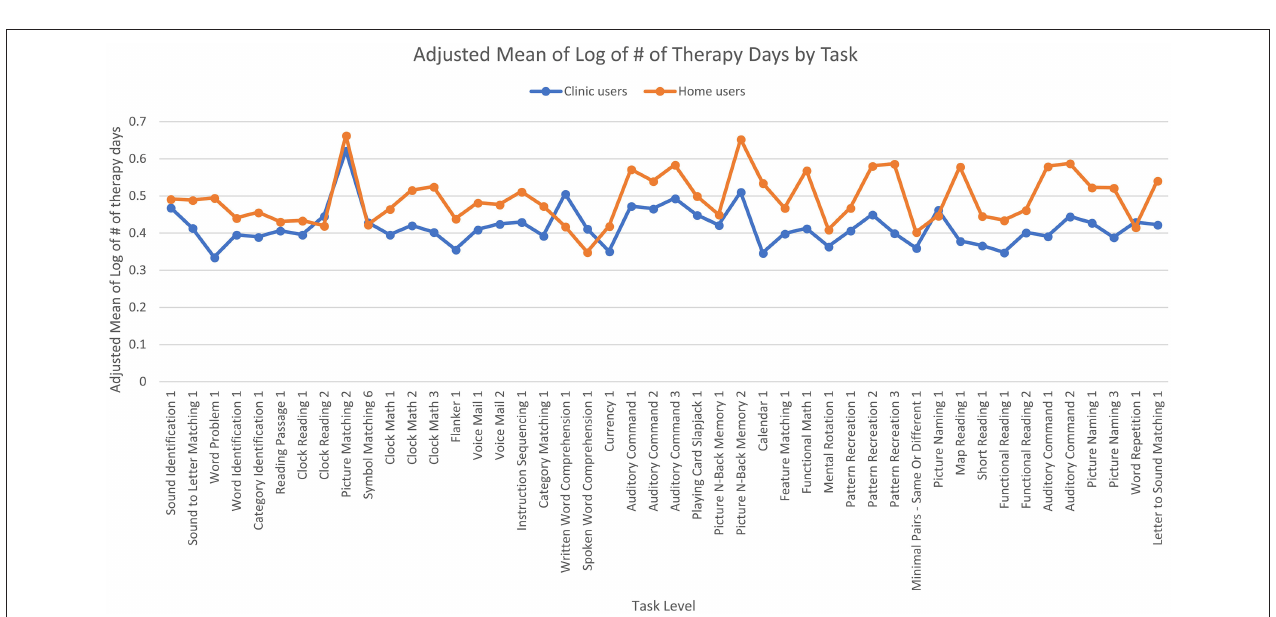
FIGURE 3 | Adjusted means for the median number of days between each therapy session by user group. Covariates appearing in the model are evaluated at the following values: years since injury = 2.10, age = 61.62.